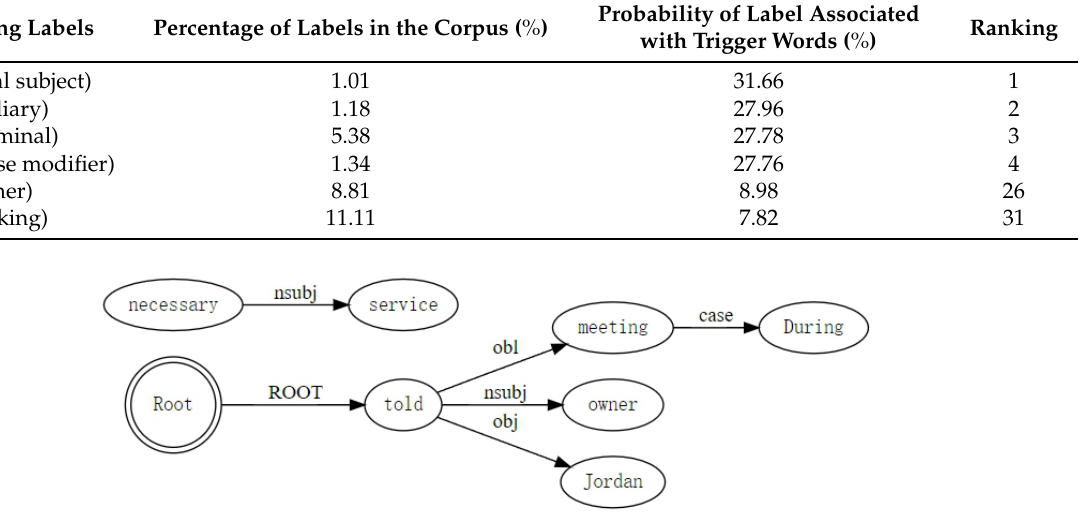
Table 1. Statistics of dependency parsing tags related to trigger words on ACE2005 dataset.